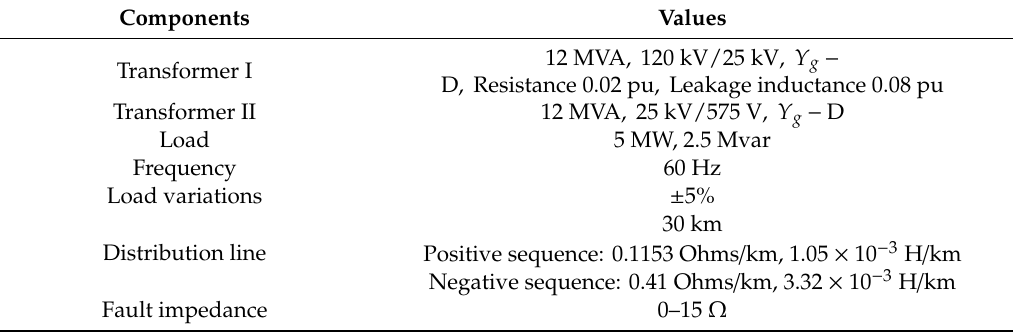
Table 1. Parameters of the distribution network for scenario I.